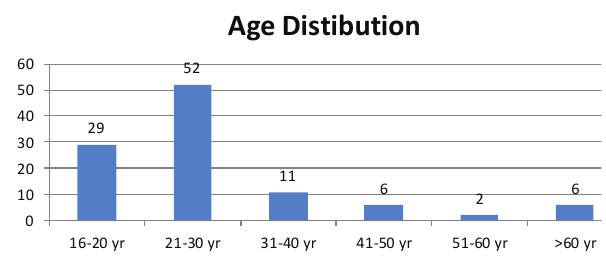
Figure 1: Age distribution of patients (in years)